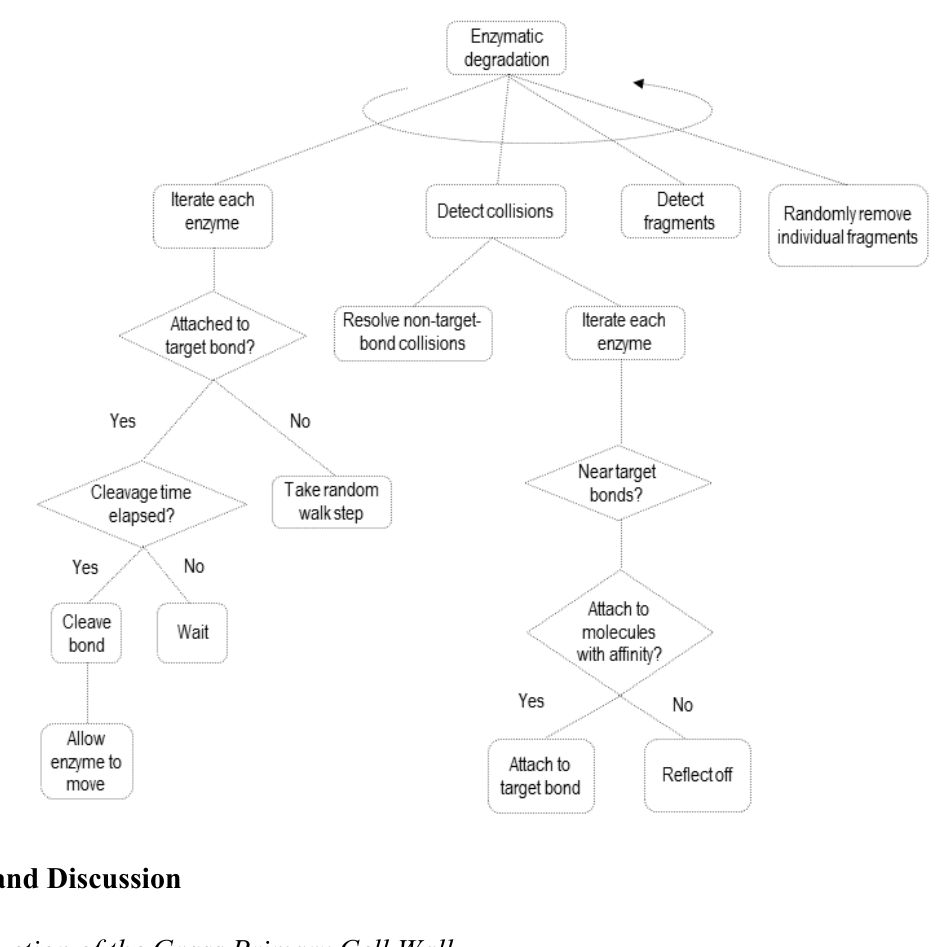
Figure 1. Structure diagram indicating the algorithm for simulating the enzymatic degradation of grass primary cell walls. A curved arrow through lines indicates continuous repetition; diamond shaped boxes indicate decision